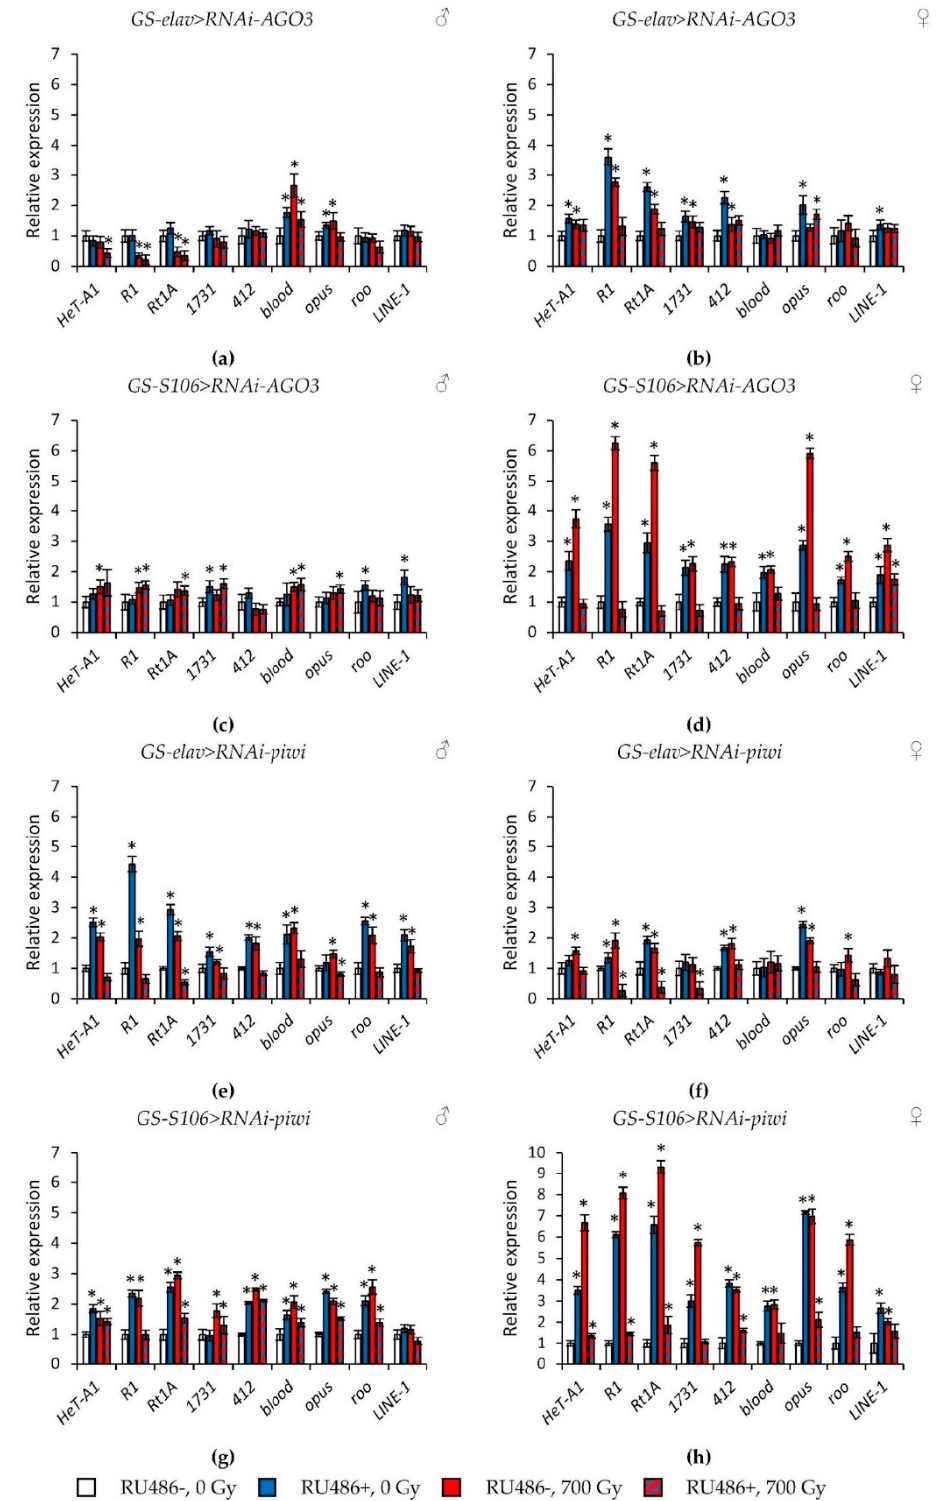
Figure 6. Changes in the expression of retrotransposons in irradiated and unirradiated males ( a , c , e , g ) and females ( b , d , f , h ) with AGO3 ( a – d ) and piwi ( e – h ) knockdown. Differences between relative expression levels of retrotransposons of unirradiated flies without PIWI genes’ knockdown (RU486-, 0Gy) and each of other experimental variants are statistically significant with * p < 0.05 (Mann- Whitney